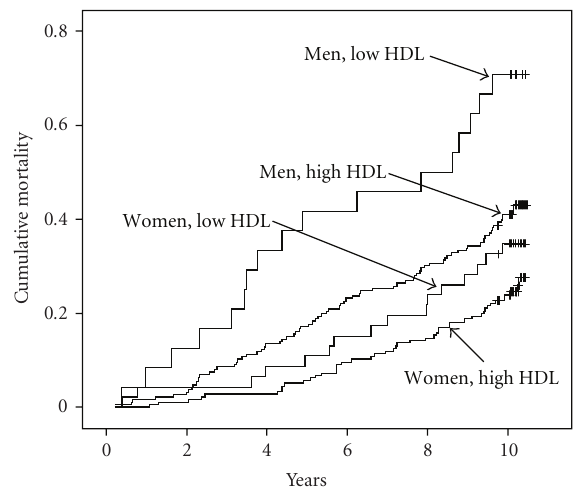
Figure 1: Kaplan-Meier curve illustrating all-cause mortality according to cuto ff levels of HDLC as recommended by the National Cholesterol Education Program—Adult Treatment Panel III (men: low HDL < 40mgdL, high HDL = 40 mgdL; women: low HDL < 50mgdL, high HDL = 50 mgdL). Men (women) at risk at 2,4,6, and 8 years was 197 (218), 172 (213), 152 (198), and 138 (185).